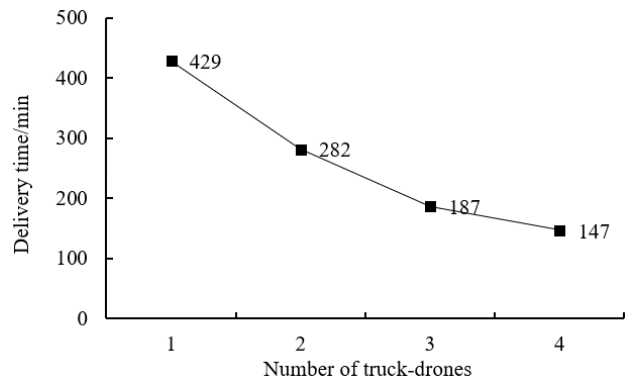
Figure 6. Sensitivity analysis of the number of truck–drones.